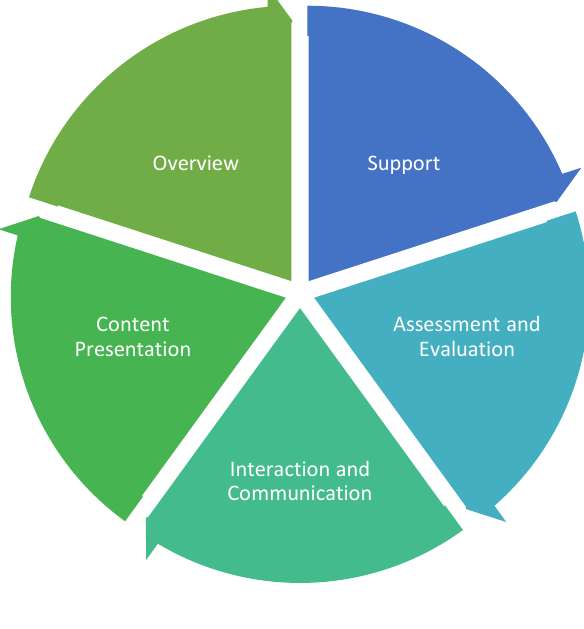
Online Course Design Elements Framework